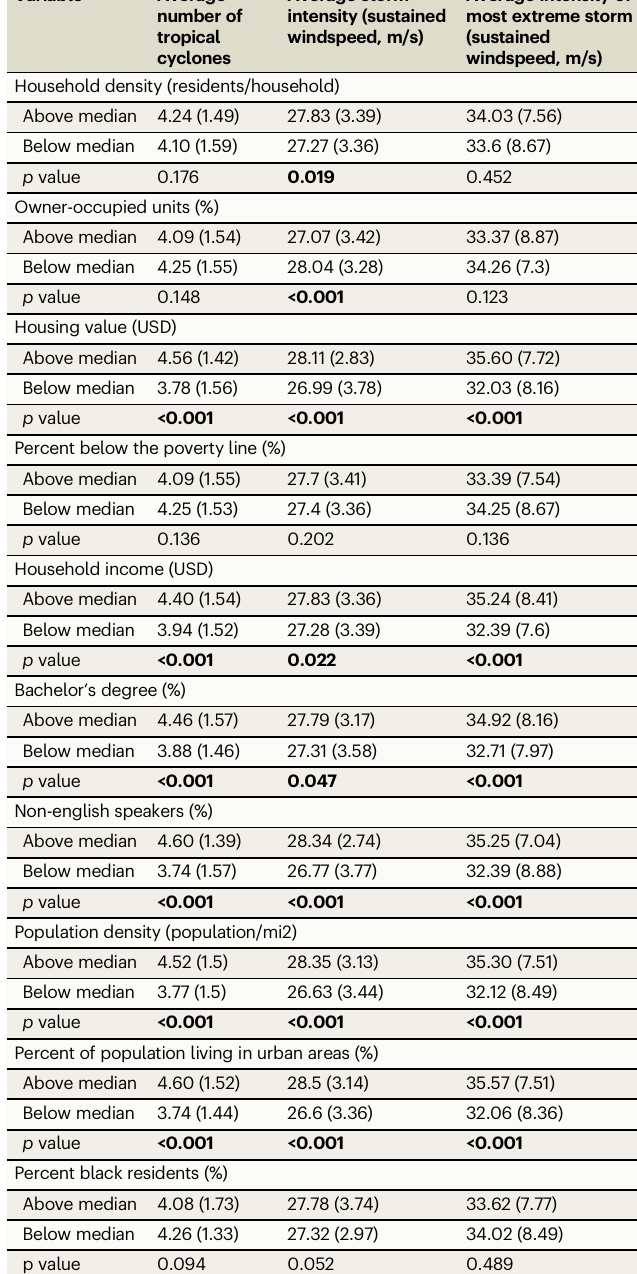
Table 2 | Tropical cyclone exposure metrics across included ZCTAs in Florida during the study period (1999 – 2016), strati- fi ed by whether they are above or below the Florida